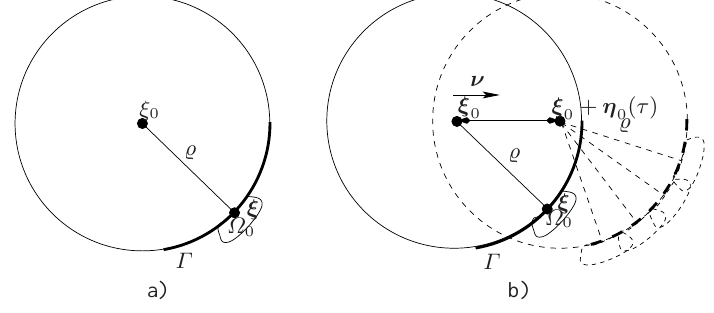
Figure 2. The behaviour of the circular